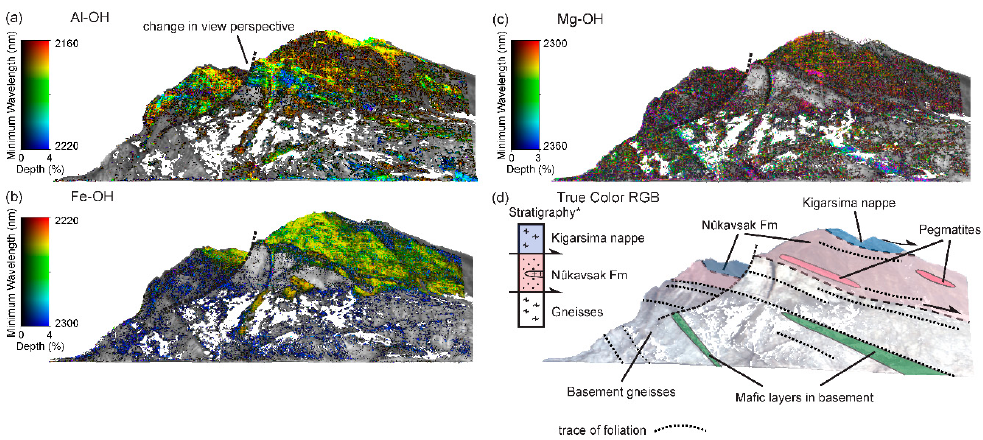
Figure 7. Wavelength position maps of the Karrat area, highlighting lithological variations associated with differences in the abundance of: ( a ) AlOH; ( b ) FeOH; and ( c ) MgOH bearing minerals draped on a grayscale pseudo-orthophoto. Non-geological material (such as vegetation) and areas strongly affected by shadows were masked and excluded from HIS data cubes before applying the wavelength mapping method and are indicated by white pixels. ( d ) Spatial context is provided by the true color pseudo-orthophoto. See Section 3.2.1 for a detailed description of matching hyperspectral products to the pseudo-orthophoto.